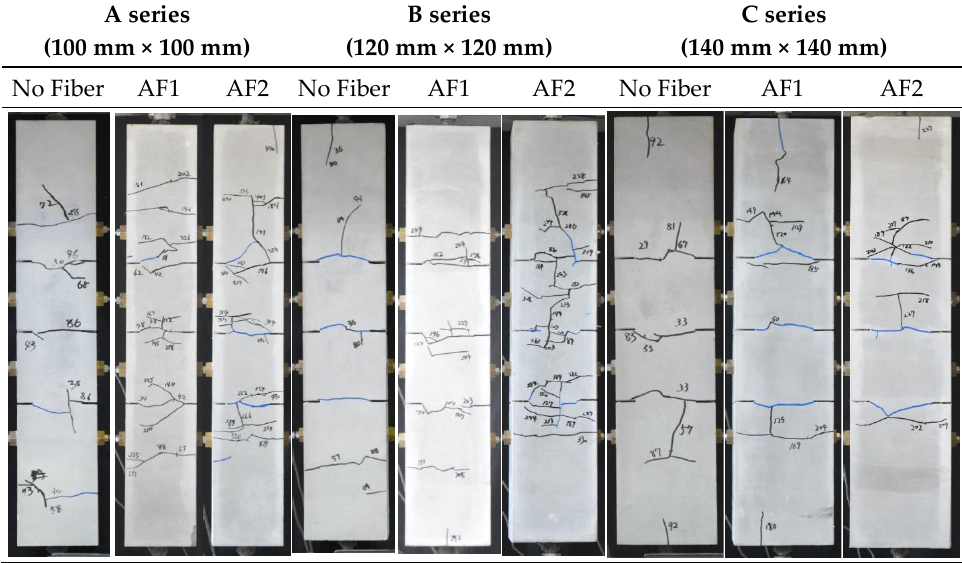
Figure 11. Examples of crack patterns after steel rebar yielding [24].